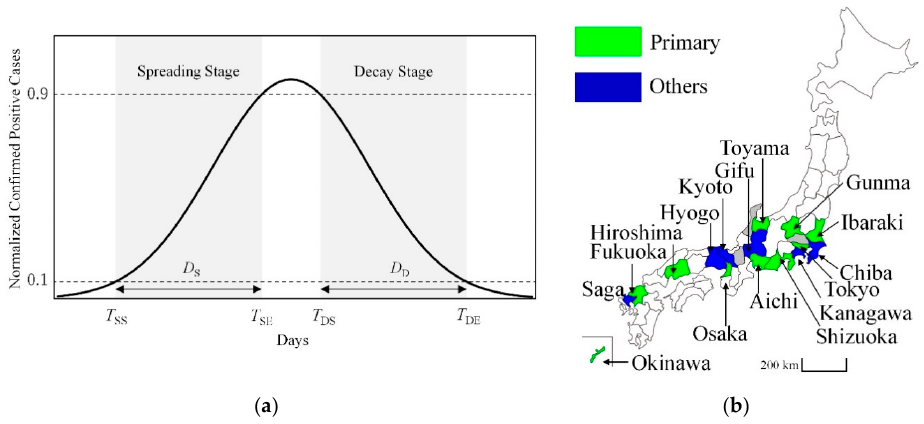
Figure 1. ( a ) Proposed definition of the spread and decay durations along the curve of the COVID-19 pandemic, which has been applied to the 7-day moving average of original data. Time parameters extracted from the definition are T SS (start of spread), T SE (end of spread), T DS (start of decay), T DE (end of decay), D S (spread duration), and D D (decay duration). ( b ) Map of Japan with 16 prefectures under study classified as primary prefectures and adjacent prefectures (others).